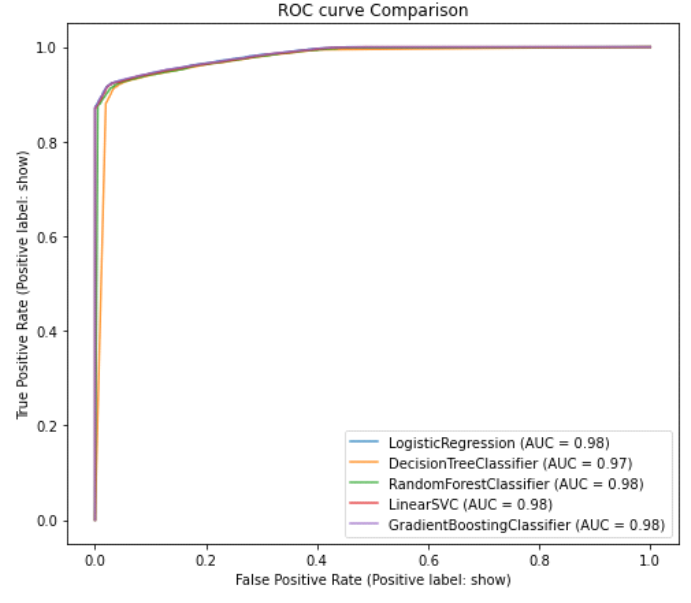
Figure 7. Receiver operating characteristic curve